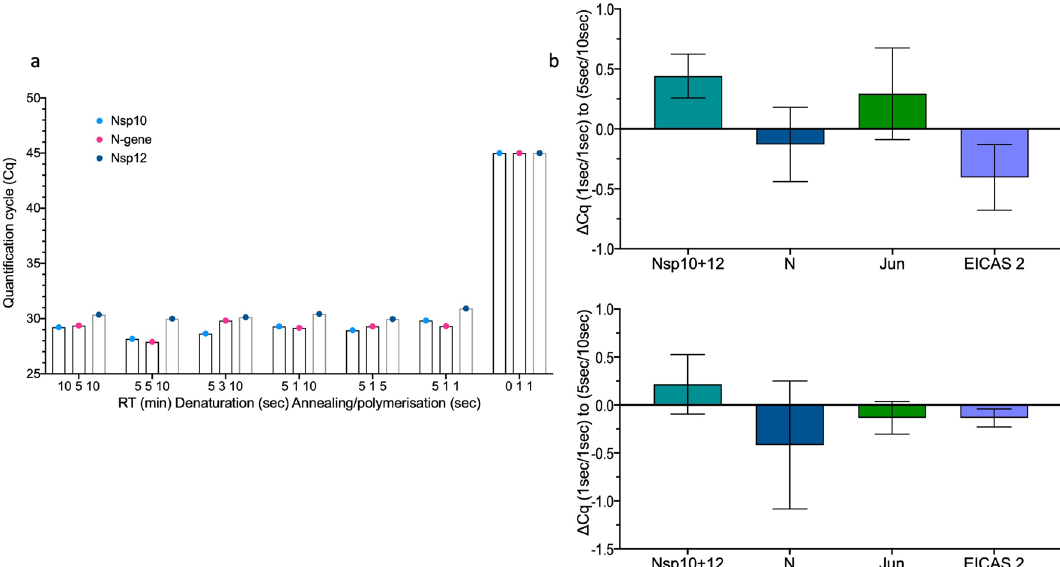
Figure 4. Reduction in qPCR times. ( a ) Cqs obtained for Nsp10, 12 and N-gene by reduction of qPCR times from 5 s denaturation and 10 s annealing polymerisation to 1 s each. ( b ) Comparison of the initial (5 s/10 s) and